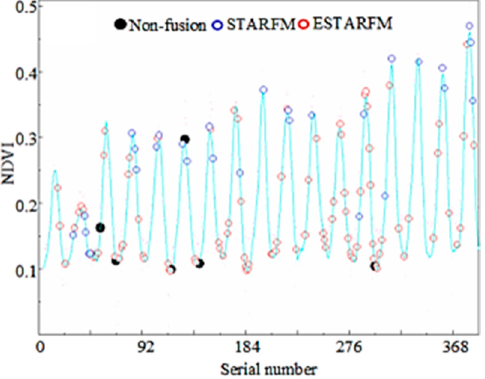
Figure 5. All predicted images from 2000 to 2016 where the spatio-temporal fusion algorithms were selected based on the screening rule. The non-fusion represents no suitable spatio-temporal algorithm.